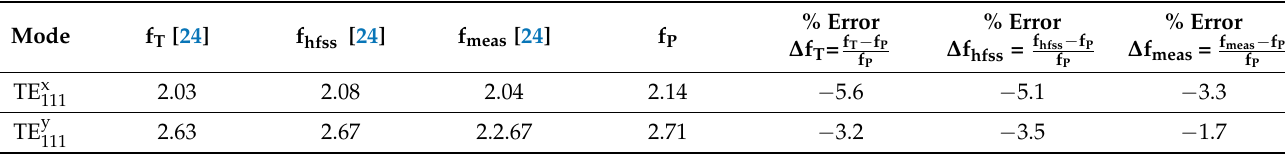
Table 3. Comparison of the resonant frequencies of the CP hollow inhomogeneous RDRA [24] and hollow RDRA having